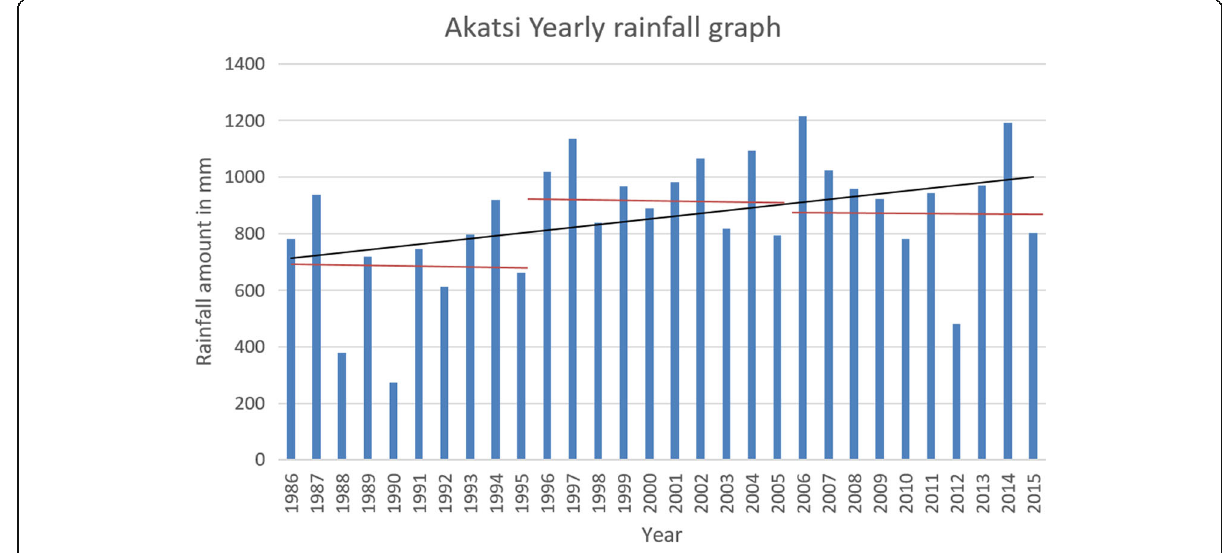
Fig. 3 Annual Rainfall (distribution) in Akatsi with the general and decadal trend lines (Data source